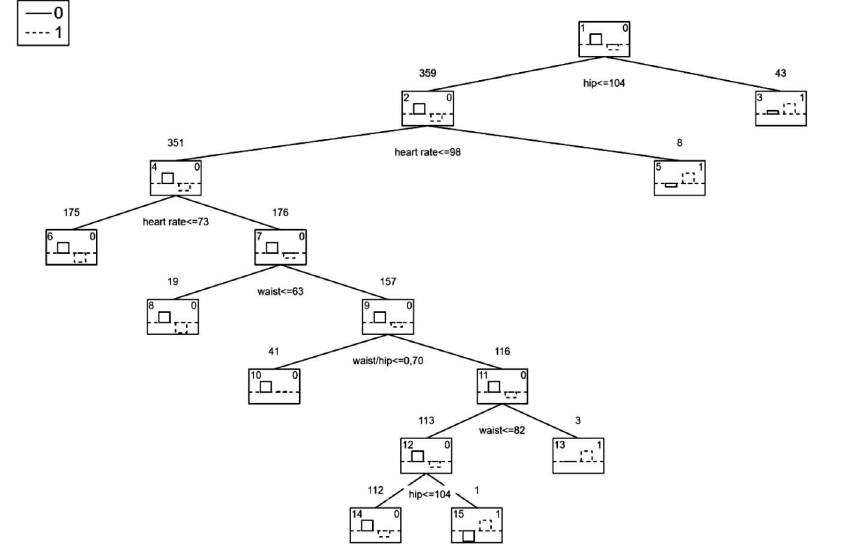
Figure 1. The classification tree for